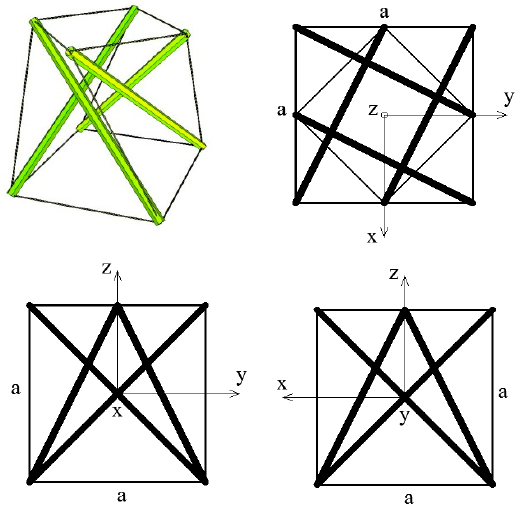
Figure 1. Geometry of a unit cell—a 4-strut simplex module—axonometry and three views.